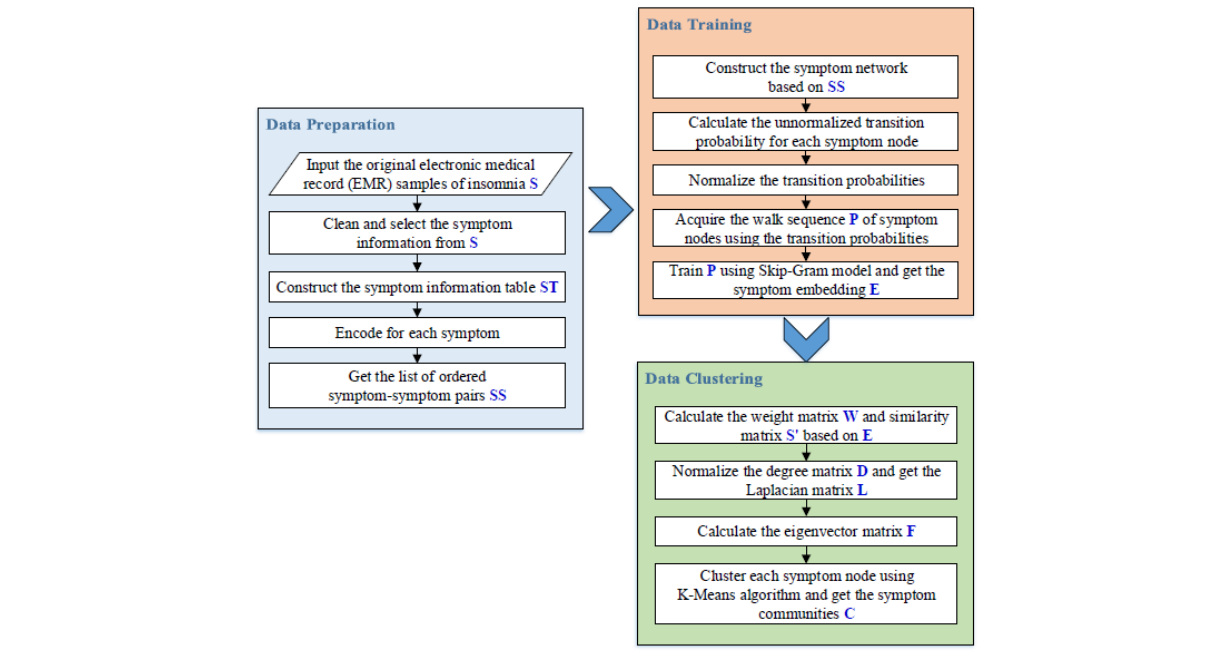
Figure 1. Flowchart of data